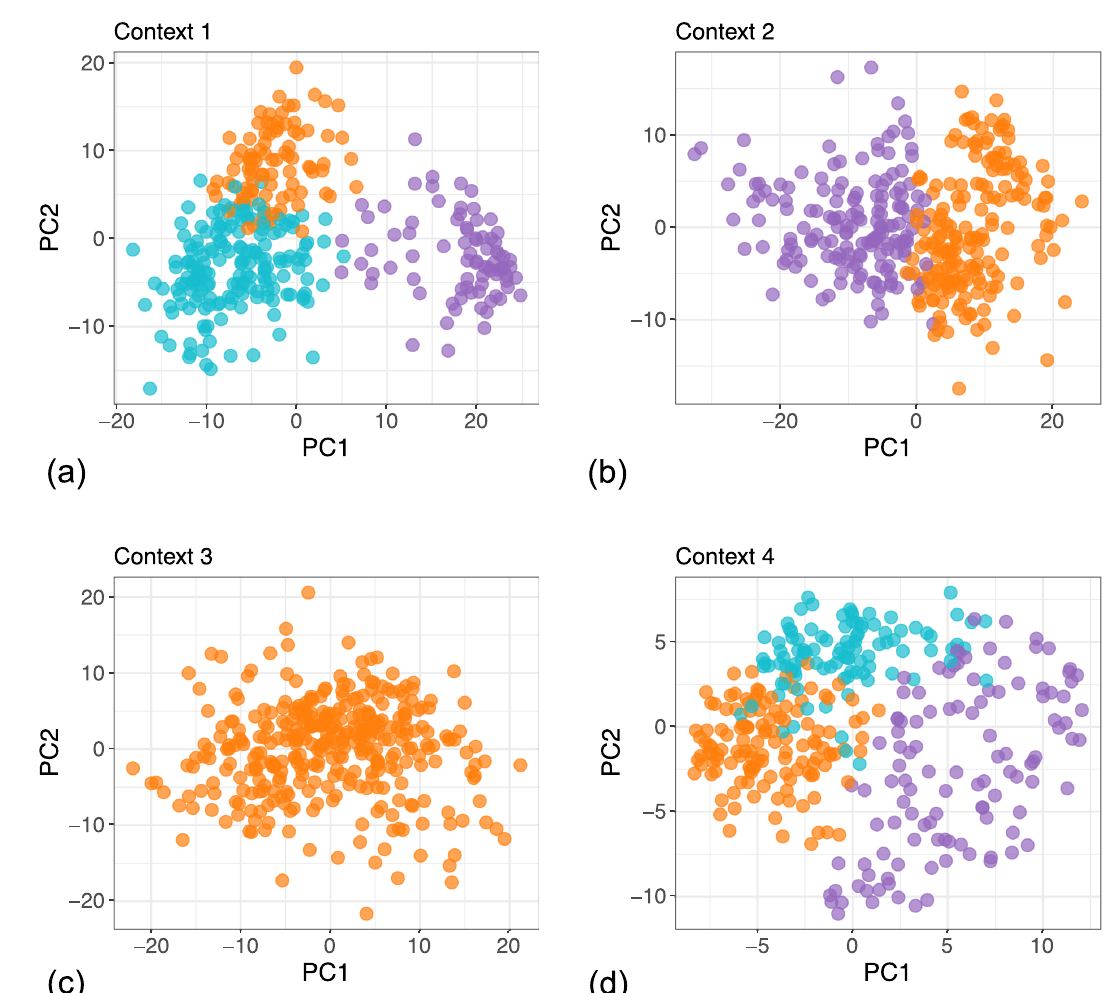
Fig 8. PCA projection of the local clusters identified in individual contexts in the breast cancer dataset from TCGA, from the model with 3 context-specific clusters and up to 18 global clusters. (a) Context 1 represents the gene expressiondataset which containsthree local clusters. (b) Context 2 representsthe DNA methylationdataset and containstwo local clusters. (c) Context 3 represents the miRNA expressiondataset with only 1 cluster. (d) Context 4 correspondsto the RPPA dataset, which containsthree local